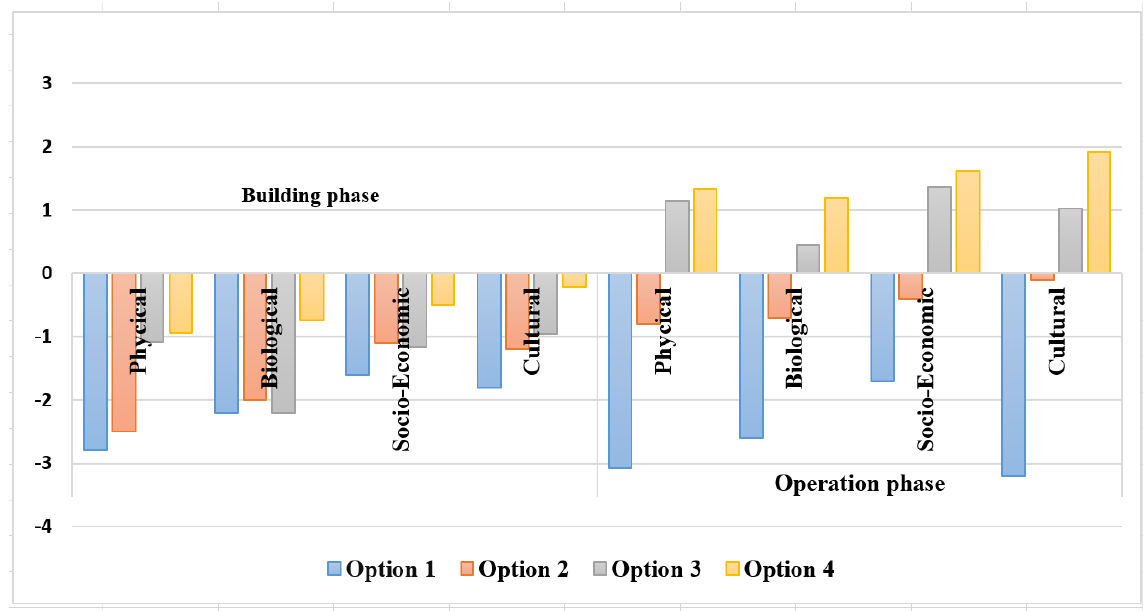
Figure 2. Iranian Leopold matrix analysis for all options in the two stages of construction and